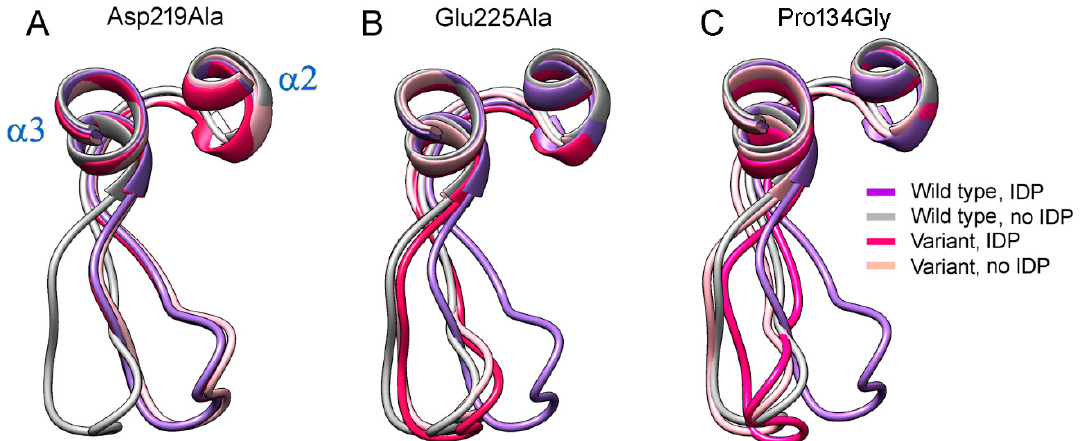
Figure 8. The effects of three amino acid substitutions on loop 2–3 conformation in dimeric Vr-mPPase containing IDP in one subunit. ( A ) The Asp219Ala variant. ( B ) The Glu225Ala variant. ( C ) The Pro134Gly variant. Each panel shows wild- type mPPase data for comparison. The color scheme defines the Vr-mPPase type and subunit occupancy by IDP.